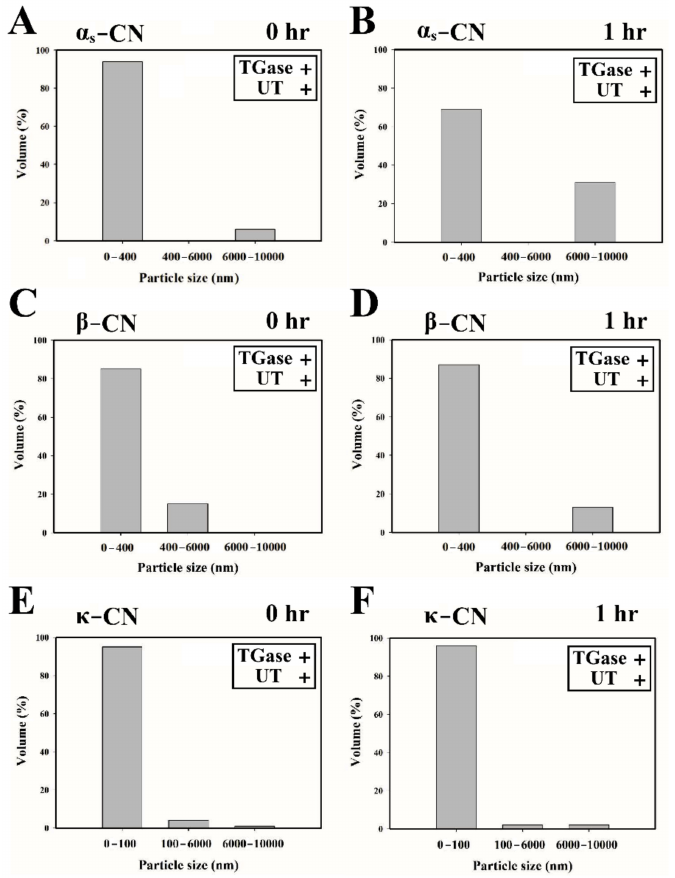
Figure 5. Particle size distribution of the individual α s -CN, β -CN and κ -CN treated with TGase (6.0 units/mL) and UT at 30 ◦ C for 0 and 60 min. ( A ) α s -CN for 0 min, ( B ) α s -CN for 60 min, ( C ) β -CN for 0 min, ( D ) β -CN for 60 min, ( E ) κ -CN for 0 min, and ( F ) κ -CN for 60 min. The experiments on the sample were performed in